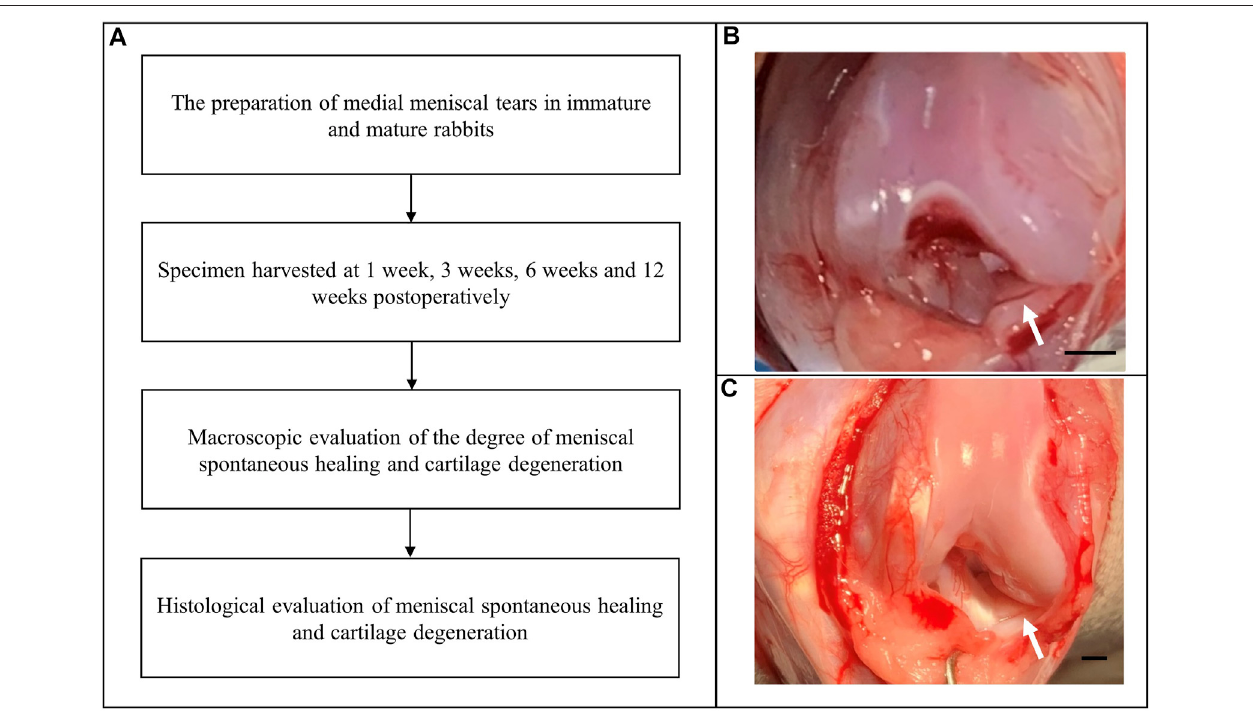
FIGURE1| Flowdiagramshowingcreationofthemedialmeniscaltearmodel. (A) Theexperimental fl owdiagram. (B) Creationof “ parrotbeak ” tearsintheanterior horn of the medial meniscus of the right knee in immature rabbits. Scale bar: 1 mm. (C) Creation of “ parrot beak ” tears in the anterior horn of the medial meniscus of the right knee in mature rabbits. The white arrows indicate meniscal tears. Scale bar: 1